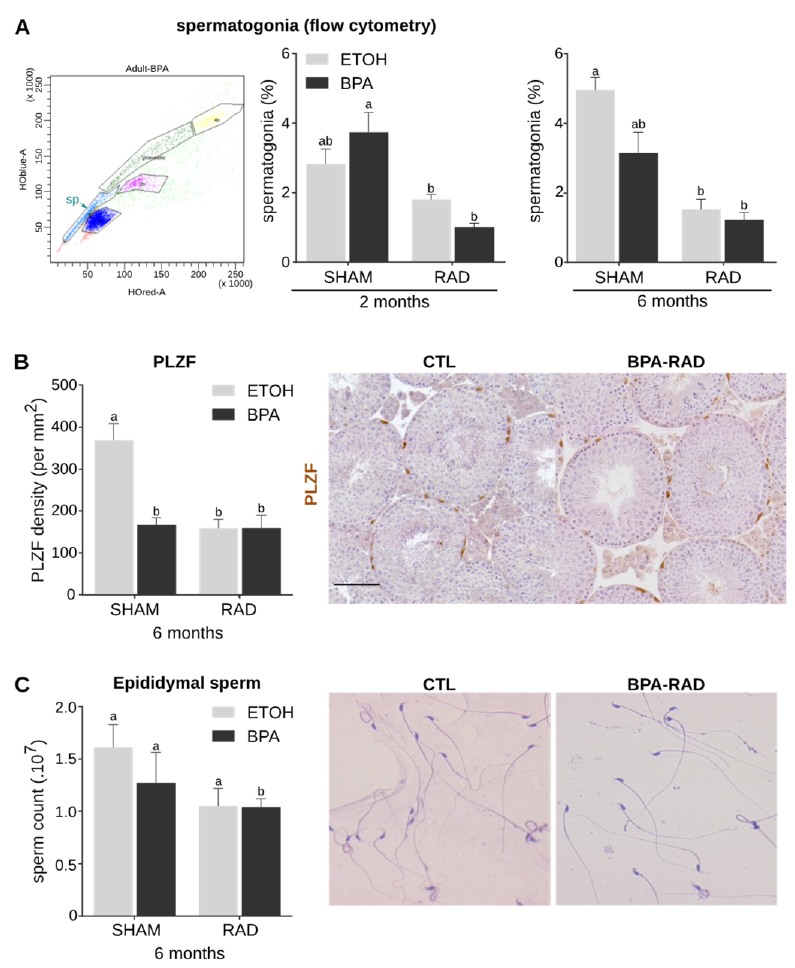
Figure 4. BPA and RAD co-exposure in utero decrease the number of spermatogonia in adult mice. Testes were collected from adult (3-month-old and 6-month-old) in utero exposed mice (BPA, RAD or combined exposure) or unexposed (CTL) mice. ( A ) Percentage of spermatogonia after flow cytometric analyses based on Hoechst and PI fluorescence and light scattering parameters. Left panel: Representative flow cytometry analysis with the side population (sp) corresponding to spermatogonial cells. Middle and right panels: “sp” cell percentage in the total germ cell fraction (sp, premeiotic, 4n, 2n and n germ cells) at 3 months (middle panel) and 6 months (right panel). Each bar represents the mean ± sem from 5–12 independent samples. Means with different letters are significantly different ( p < 0.05; two-way ANOVA followed by a Tukey test). ( B ) Density of PLZF positive cells per seminiferous tubule area (mm 2 ). Each bar represents mean ± sem from 4–5 independent samples. Means with different letters are significantly different ( p < 0.05; two-way ANOVA followed by a Tukey test). Right panels show representative pictures of the staining in control (CTL) and co-exposure (BPA-RAD) gonads. Bars represent 50 µ m. ( C ) Sperm count in the epididymis. Each bar represents the mean ± sem from 4 independent samples. Different letters indicate significant differences between groups (two-way ANOVA, Tukey’s multiple comparisons test, p < 0.05). Right panels show representative sperm stained with haematoxylin/eosin